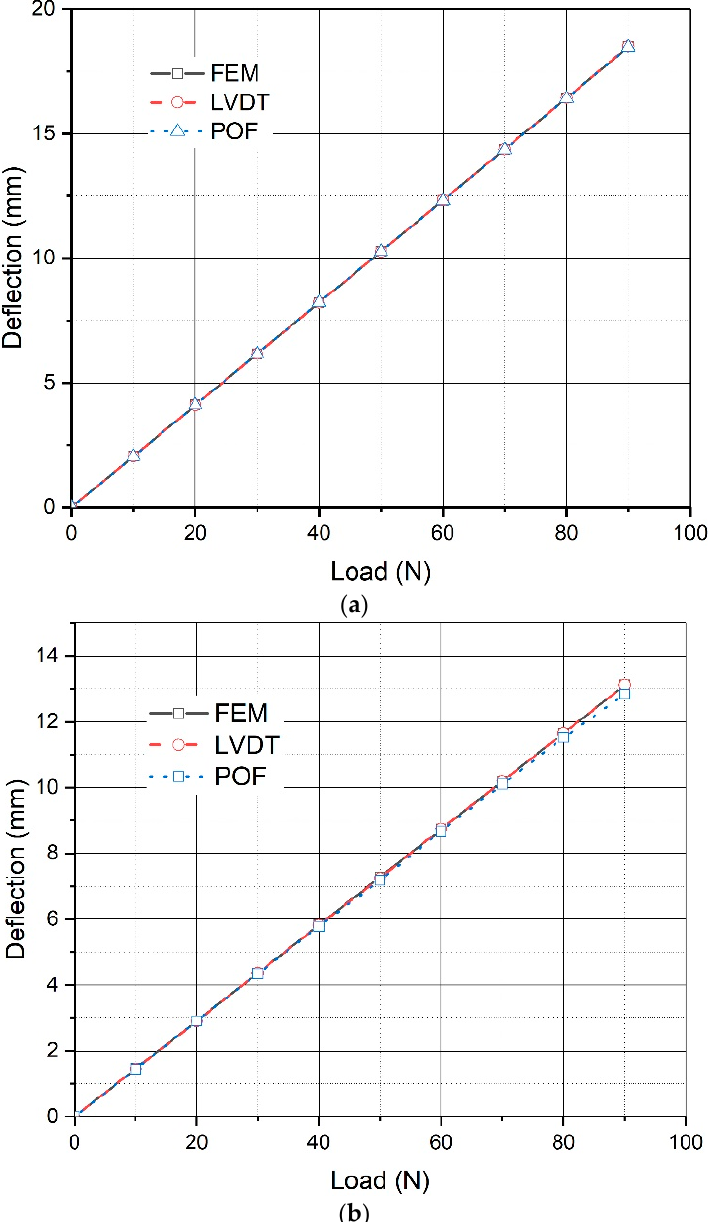
Figure 13. Comparison of the experiment results: ( a ) results at mid-span of the beam; ( b ) results at the quarter-span of the beam. Note: FEM = Finite element method.